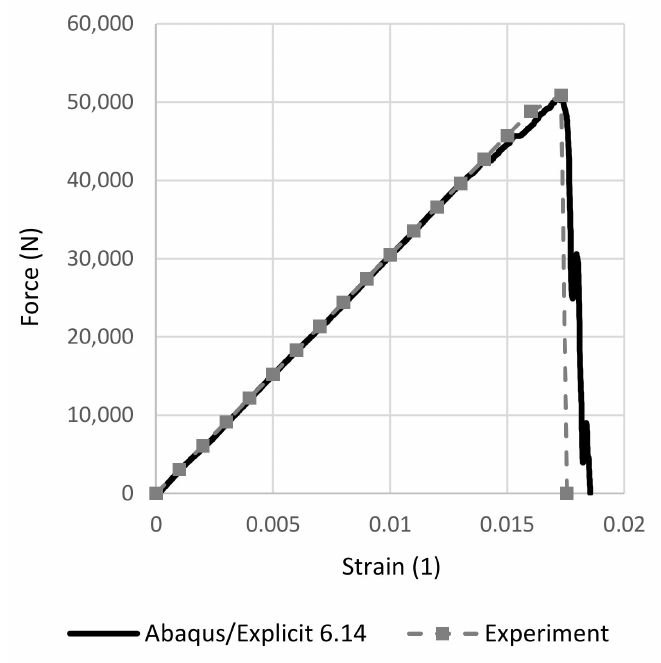
Figure 9. Force–strain FEM tensile sample response.